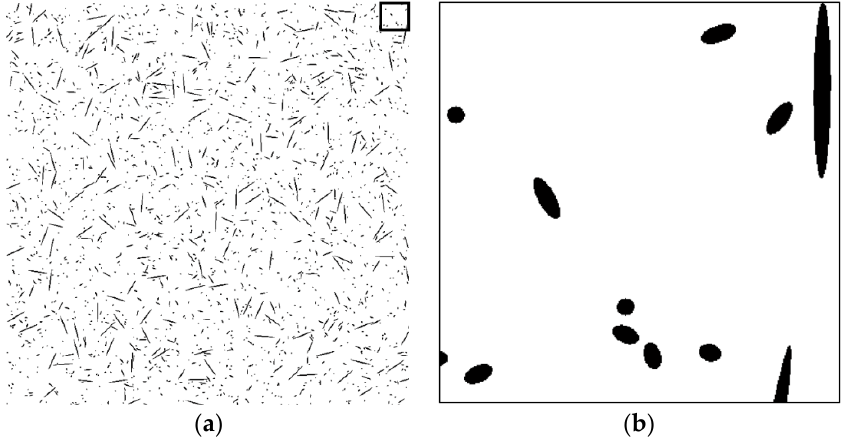
Figure 6. Artificial fiber images with a diameter of 15 pixels in a three ‐ dimensional random distribution in the area of 6000 pixels by 6000 pixels (I15 ‐ 3): ( a ) section image and ( b ) magnified image.